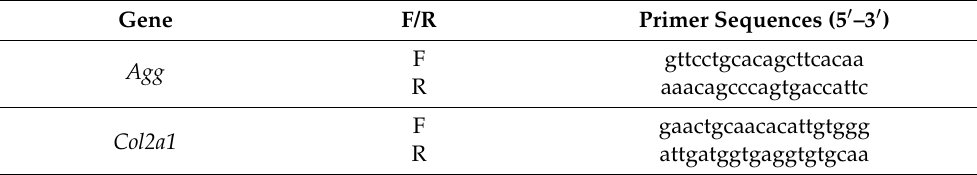
Table 1. Primers used for real-time PCR